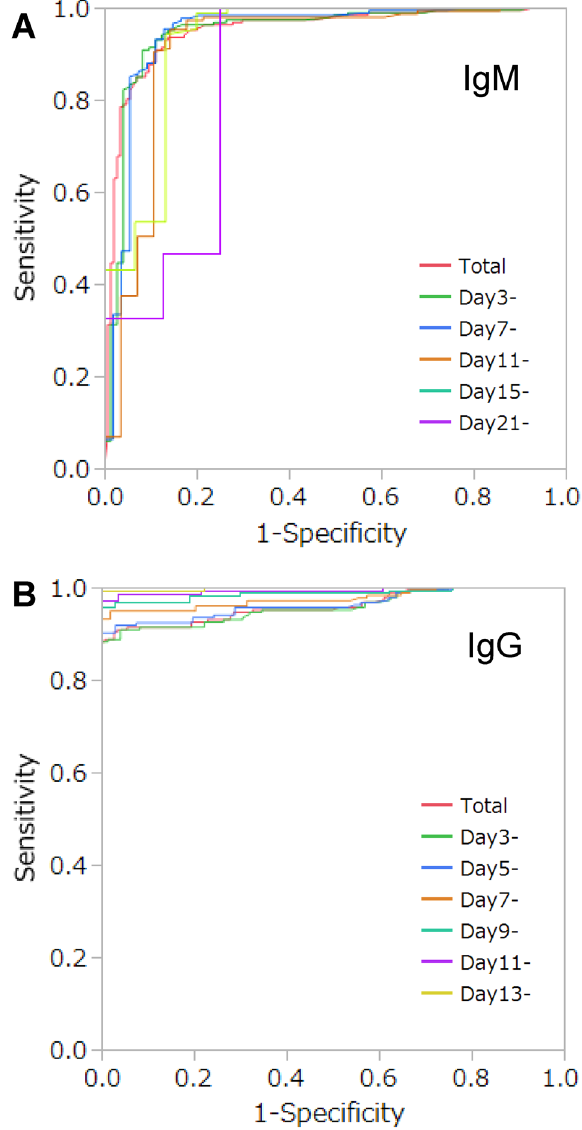
Figure 2. ROC curves for SARS-CoV-2 antibody tests. We compared the discriminating abilities of the SARS- CoV-2 IgM and SARS-CoV-2 IgG titers at different time points after symptom onset. The cutoff value for both tests was set at 10 AU/mL. ( A ) SARS-CoV-2 IgM, ( B ) SARS-CoV-2